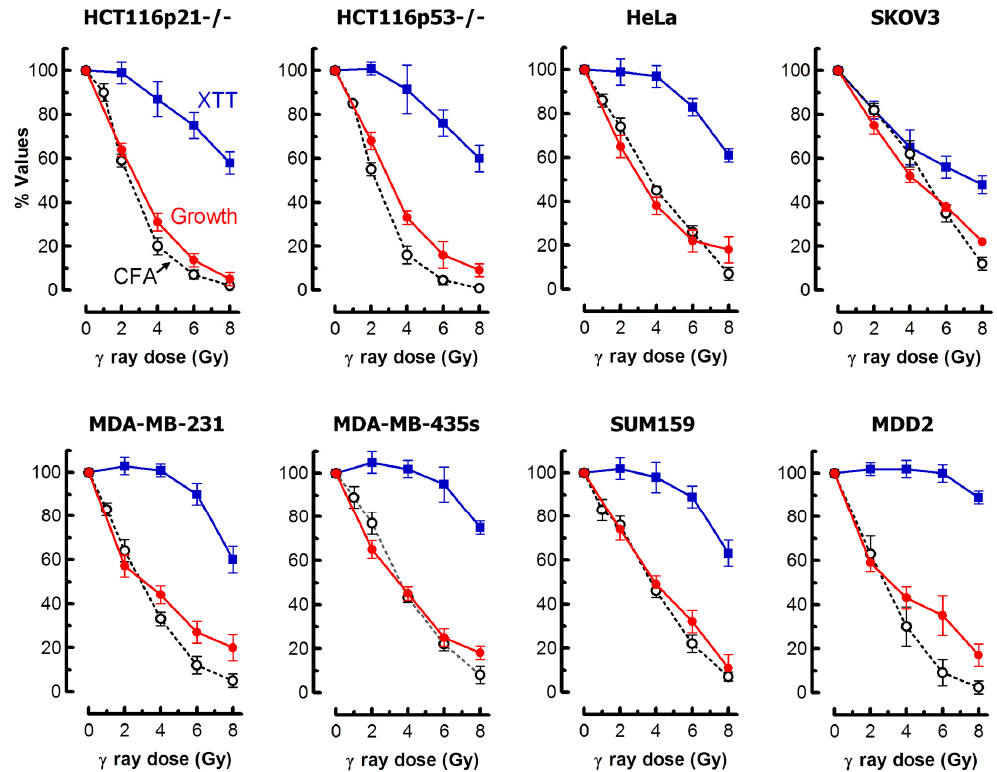
Figure 10. Radiosensitivity of the indicated cell lines evaluated by growth inhibition and XTT assays, both performed three days after irradiation. The results obtained by the colony formation assay are also shown. Bars, SE; CFA, colony forming